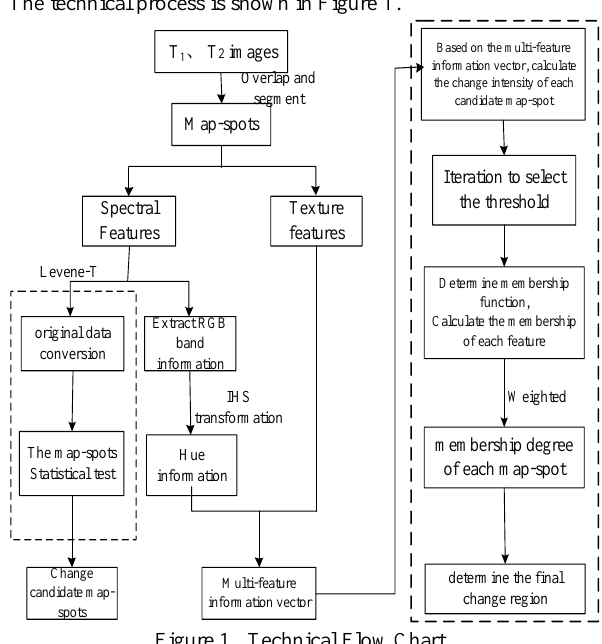
Figure 1. Technical Flow